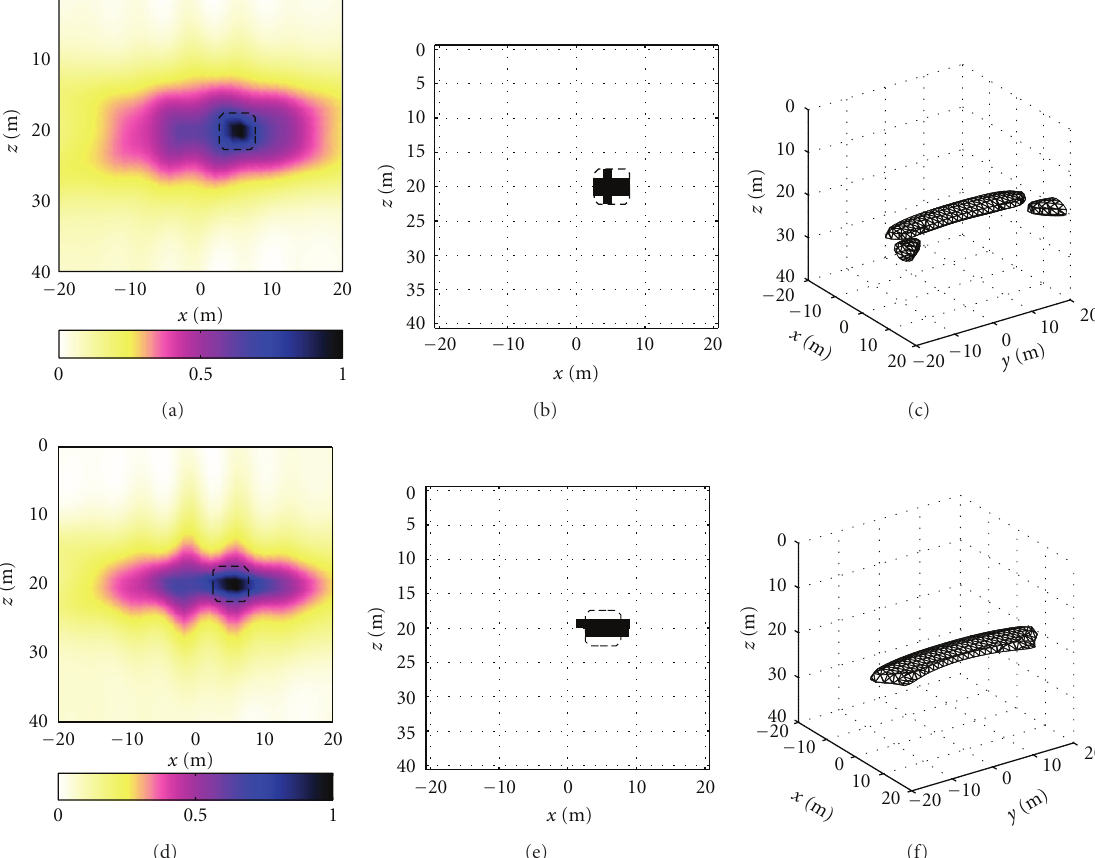
Figure 3: LSM imaging of the tunnel in the cross-hole measurement setup. Normalized logarithmic plot of the LSM indicator, binarized LSM indicator with threshold 0.75, and binarized three-dimensional LSM indicator in the whole region: (a)–(c) vertical dipoles and (d)–(f) horizontal